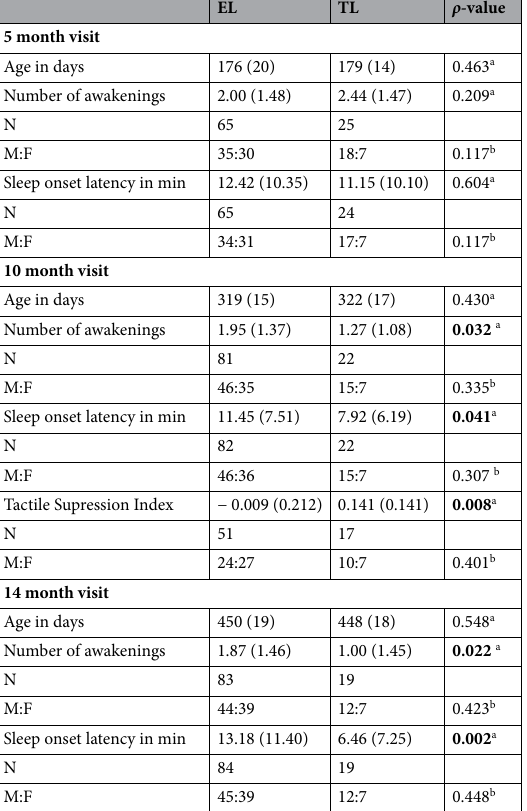
Table 1. Characteristics of participants included in data analysis at 5-, 10- and 14-month assessments. Means (standard deviation); a independent t-test; b Pearson Chi square test. Significant values are in